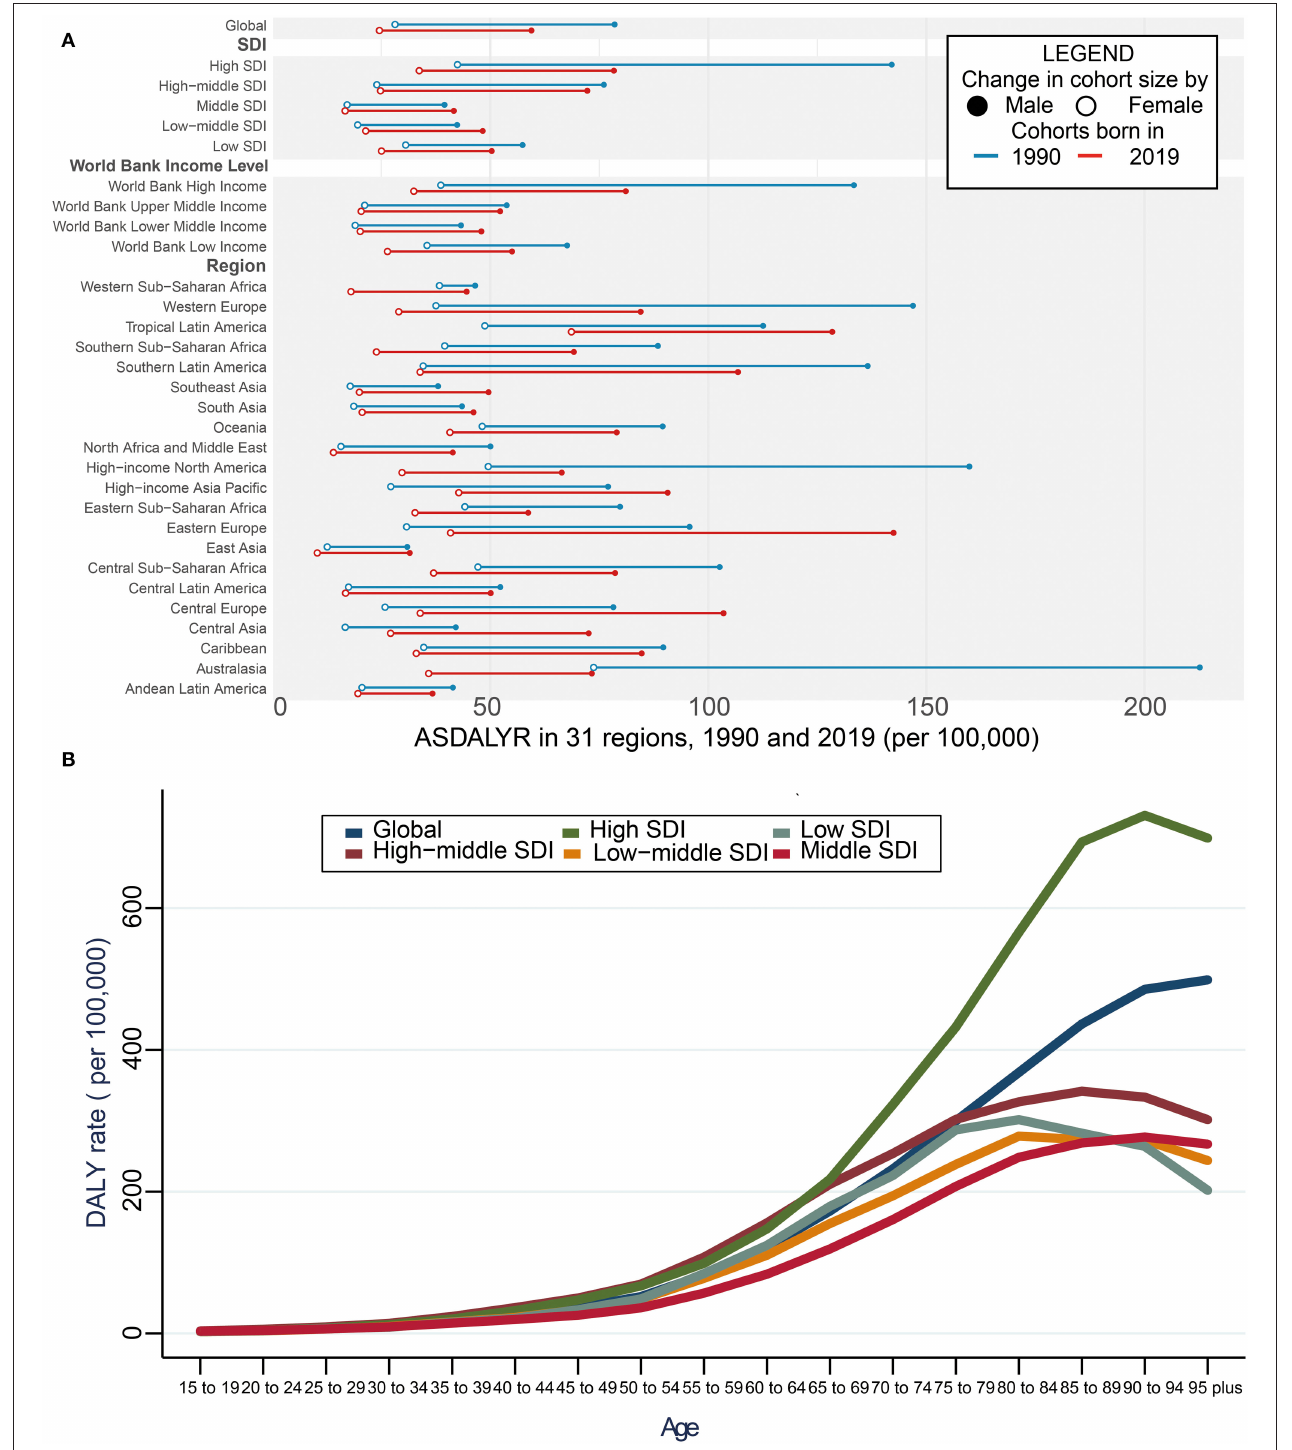
FIGURE 2 | DALYs of aortic aneurysm. (A) Global ASDALYR with 31 regions from 1990 to 2019. The blue line represents differences in ASDALYR of men and women in 1990 and the red line represents 2019 year. The black solid circle shows the male group and the hollow circle the female group. (B) Global ASDALYR stratified by age and SDI with 5 SDI regions in 2019. SDI, sociodemographic index; DALY, disability-adjusted life year rate; ASDALYR, age-standardized DALY rate.